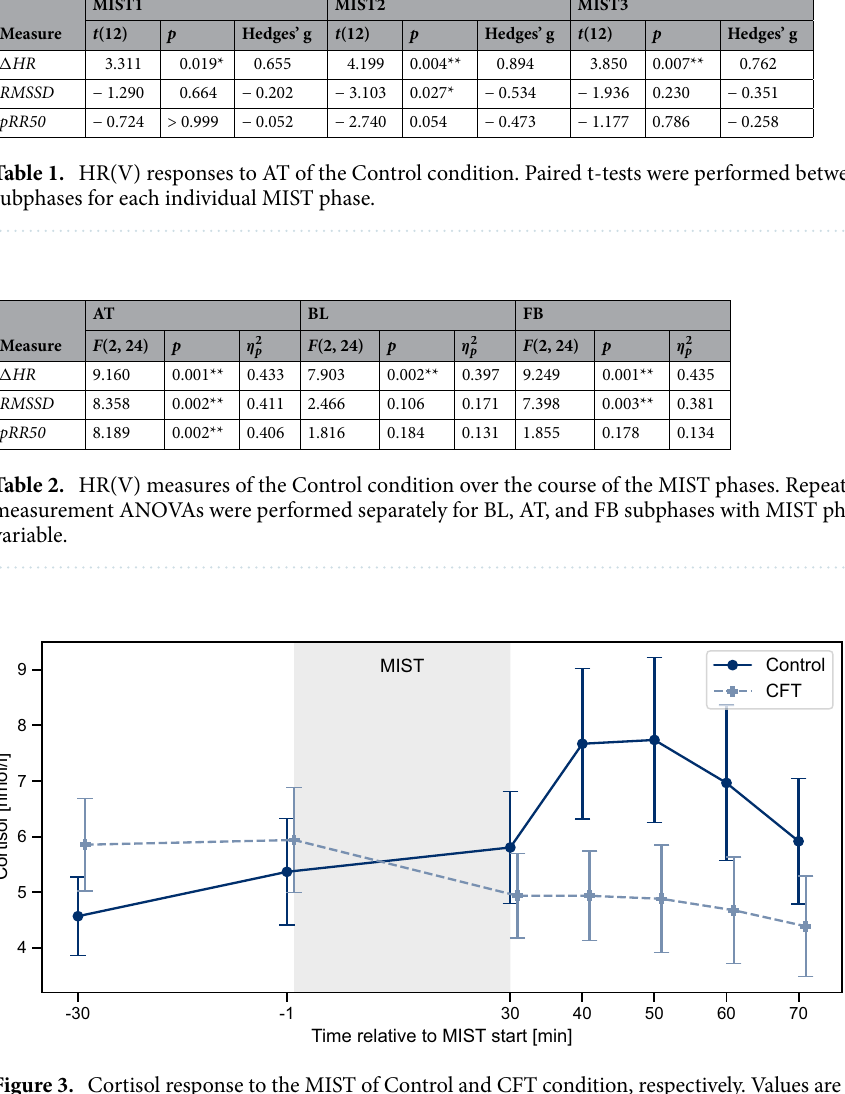
Figure 3. Cortisol response to the MIST of Control and CFT condition, respectively. Values are depicted as mean and standard error over all participants within one